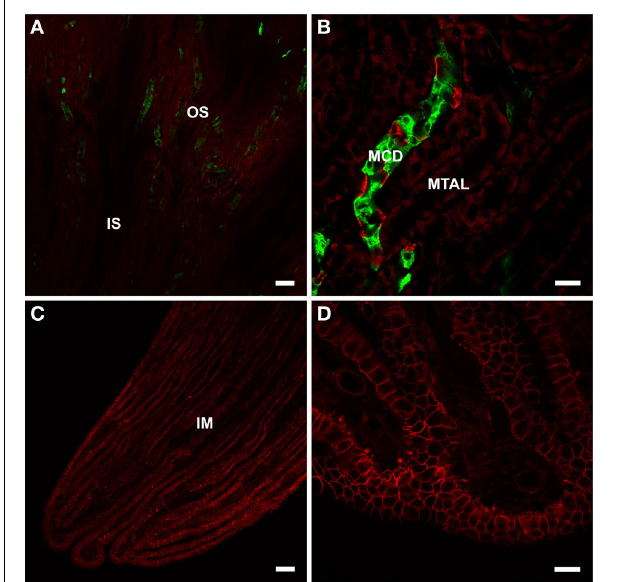
FIGURE 2 | BGT1 localization in the kidney. The kidney sections from wildtype and knockout were labeled with anti-BGT1 antibody (red; Ab#590; 1 μ g/ml), and with fluorescein-conjugated D. biflorus agglutinin (green; 1:300; marker for collecting ducts). (A,B) are from the outer strip of outer medulla, and (C,D) are from the tip of the renal papilla. The images from the sections from knockout mice are not shown here. Scale bars for (A,C) = 50 μ m; scale bars for (B,D) = 20 μ m. Immunochemistry was performed using the same materials and procedures described in detail by Zhou et al.